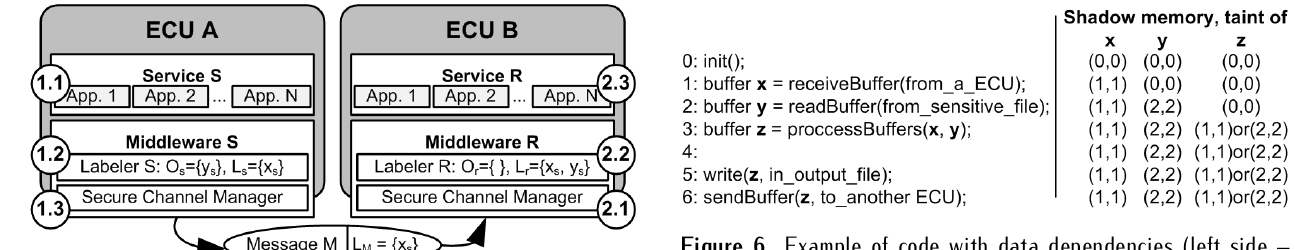
Figure 6. Example of code with data dependencies (left side – in bold, the data to taint) and its taint propagation (right